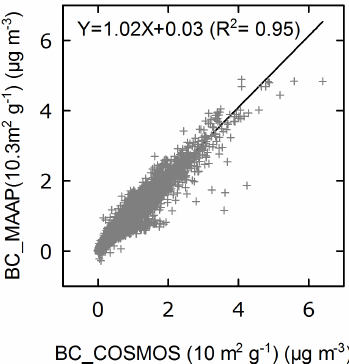
Figure 2. Correlation between hourly BC mass concentrations ob- tained using COSMOS and MAAP instruments at Fukue Island dur- ing